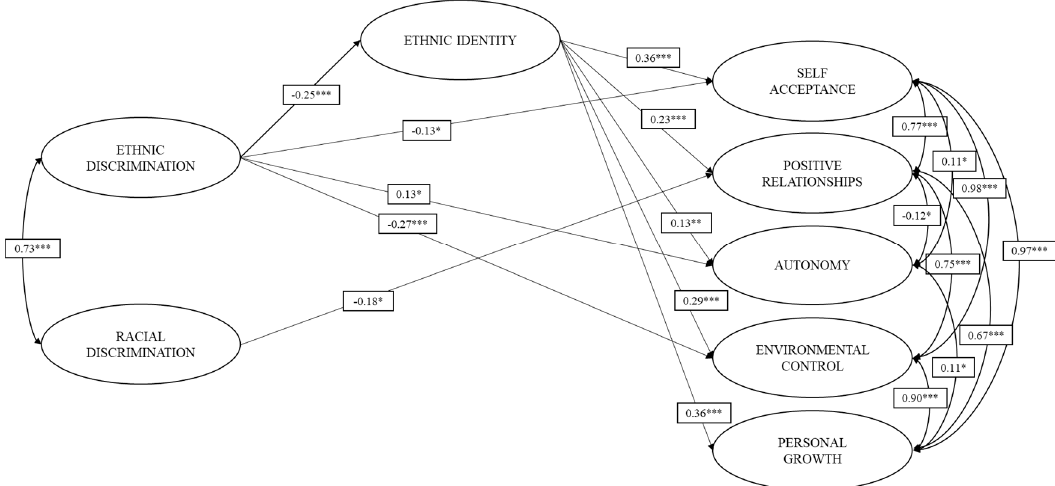
Figure 2. Mediating effect of ethnic identity on the relationship between ethnic and racial discrimination and well-being. Only the statistically significant effects of the model are plotted. * p < 0.05. ** p < 0.01. *** p < 0.001.